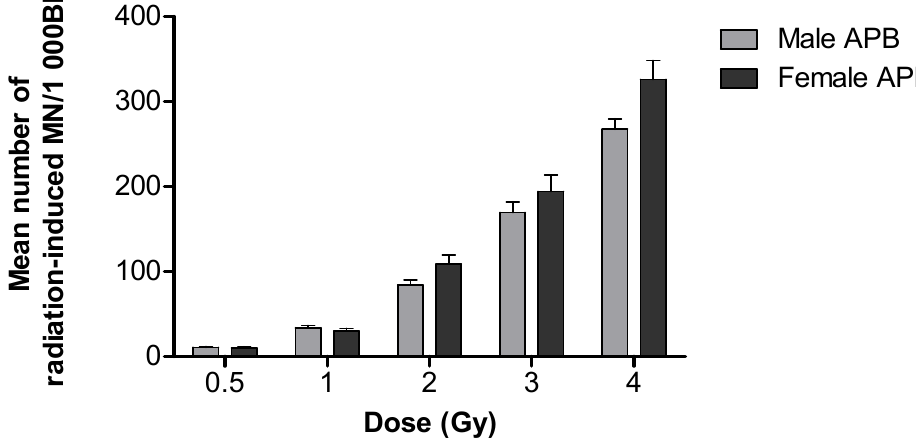
Figure 2. The mean number of radiation-induced MN in peripheral T-lymphocytes of male ( n = 13) and female adults ( n = 14) induced by 60 Co γ -rays irradiation. No significant difference was observed in MN yields between male and female adults post-irradiation ( p > 0.05). Error bars represent the standard error of the mean (SEM). At least 1000 BN cells were scored for each donor per condition.